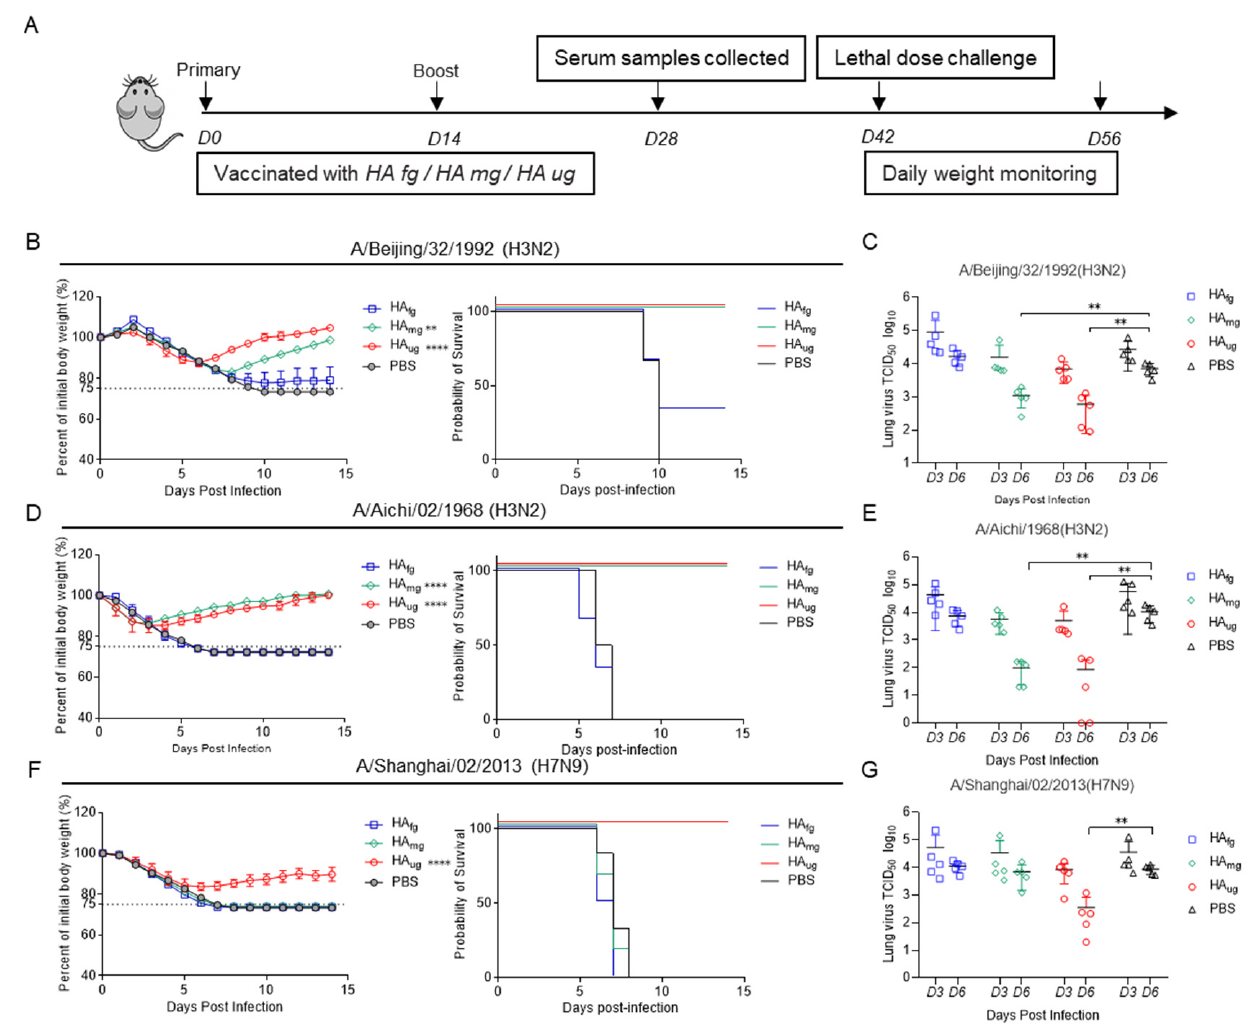
Figure 3. Deglycosylated modified Has as vaccine candidates have broad-spectrum antiviral activity against homotypic and heterosubtypic influenza A virus in mice. ( A ) Timeline of vaccination and challenge experiments in mice. Six- to eight-week-old female BALB/c mice (six mice in each group) were intramuscularly injected with 15 µ g of HA fg , HA mg and HA ug on days 0 and 14 and challenged on day 42 intranasally with 25 MLD 50 (50% mouse lethal dose) of A/Beijing/32/1992(H3N2) virus ( B ), A/Aichi/02/1968(H3N2) virus ( D ), and A/Shanghai/02/2013(H7N9) virus ( F ). Mice were monitored daily for weight loss change in each group over 14 days post-infection. Mice were euthanized when they lost 25% of their original body weight. ( C , E , G ) Virus titers were determined for lung tissues by TCID 50 assay at 3 dpi and 6 dpi post infection. Data are presented as the mean ± SEM. The results were calculated with Prism software using Student’s t test and two-way ANOVA; significant differences are marked as ** p < 0.01; **** p < 0.0001.